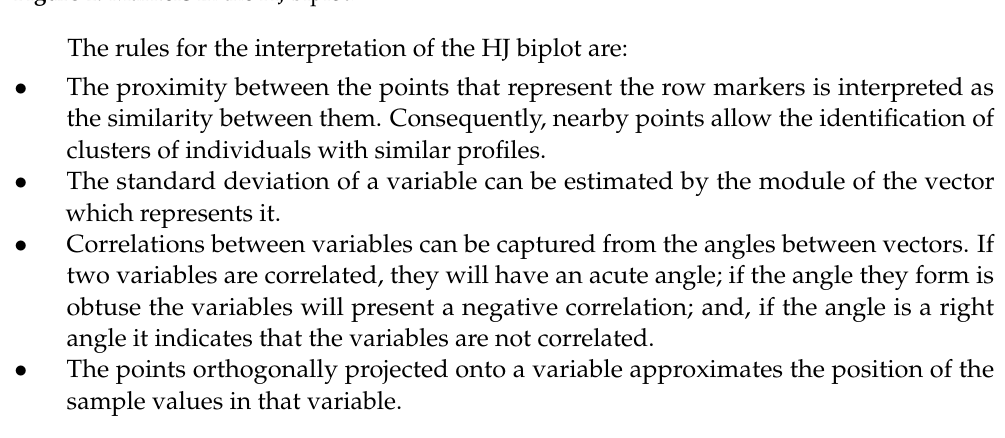
Figure 1. Markers in the HJ biplot.